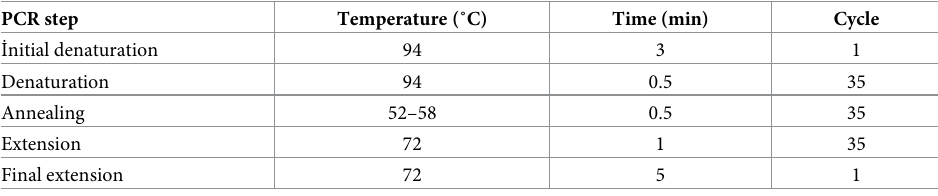
Table 2. The protocol